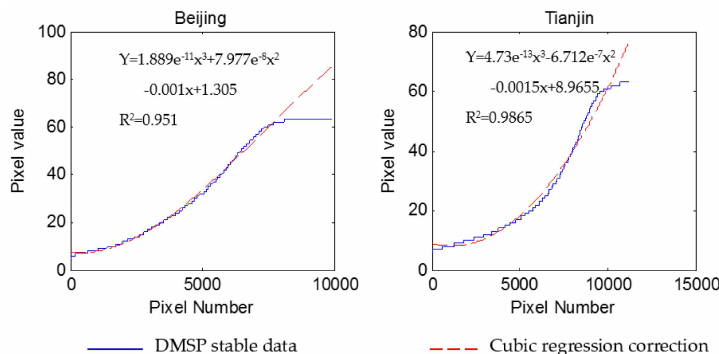
Figure 7. Correction of the saturation light by the cubic regression equation of Beijing and Tianjin,